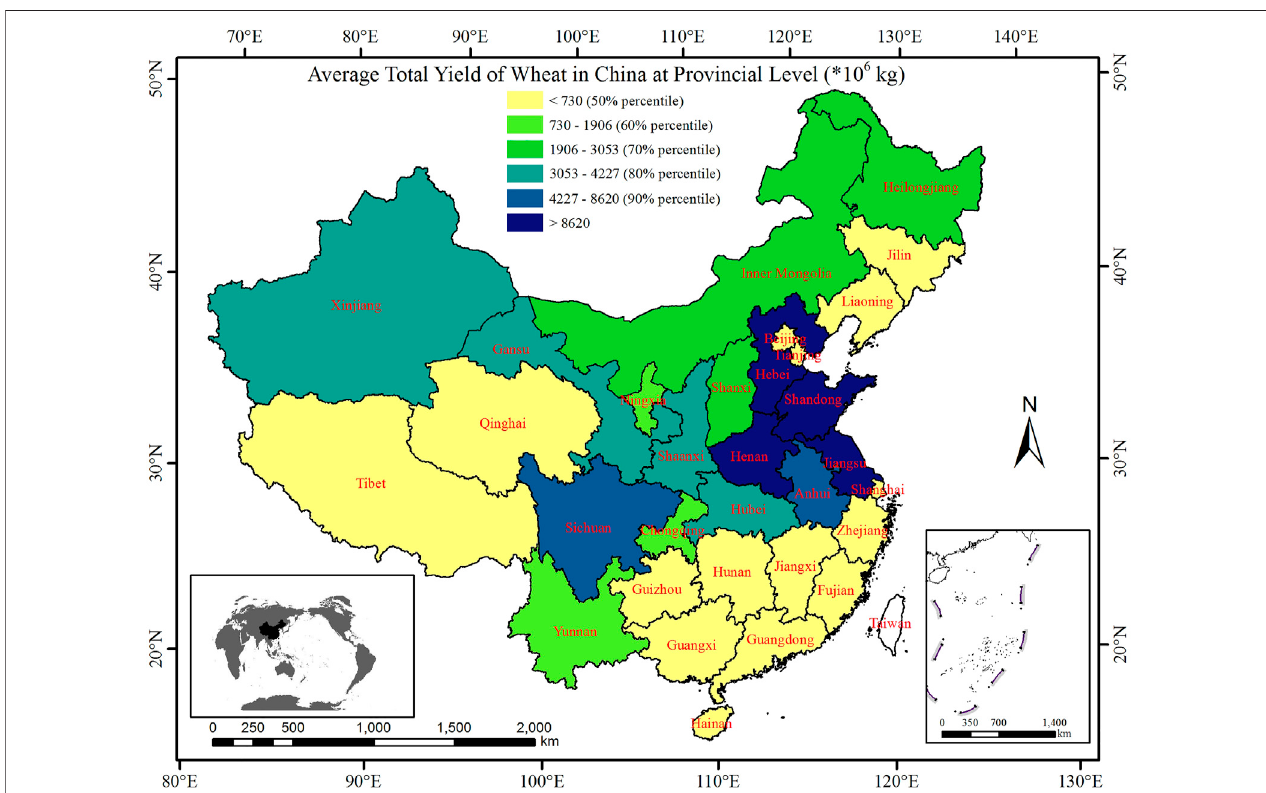
FIGURE 1 | Distribution of the average total yield of wheat in mainland China at the provincial